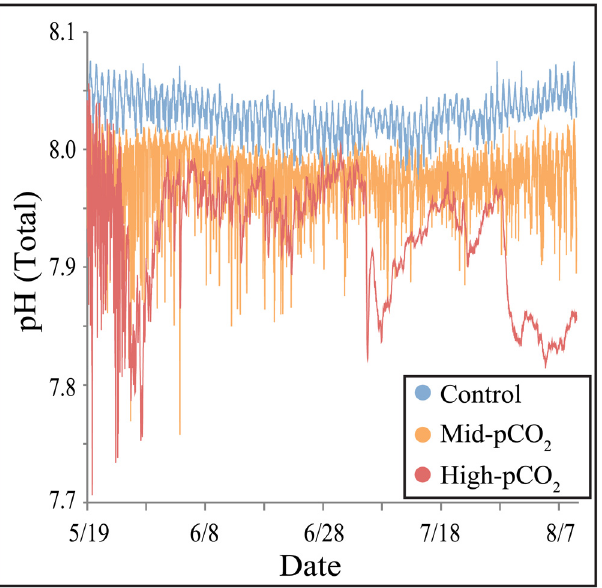
Fig 2. Seawater pH at each of the three experimental sites during the deployment of calcite blocks. Data are from Enochs et al . [38].